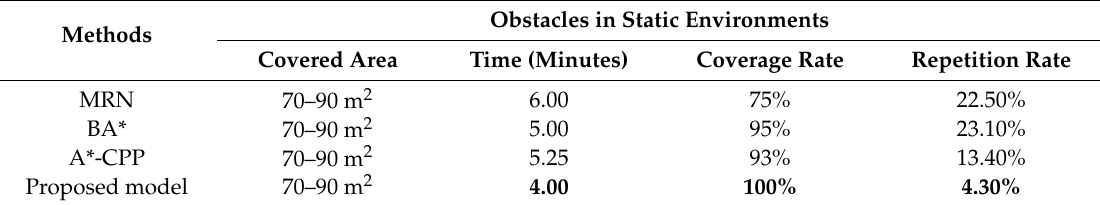
Table 4. Experimental results in a real